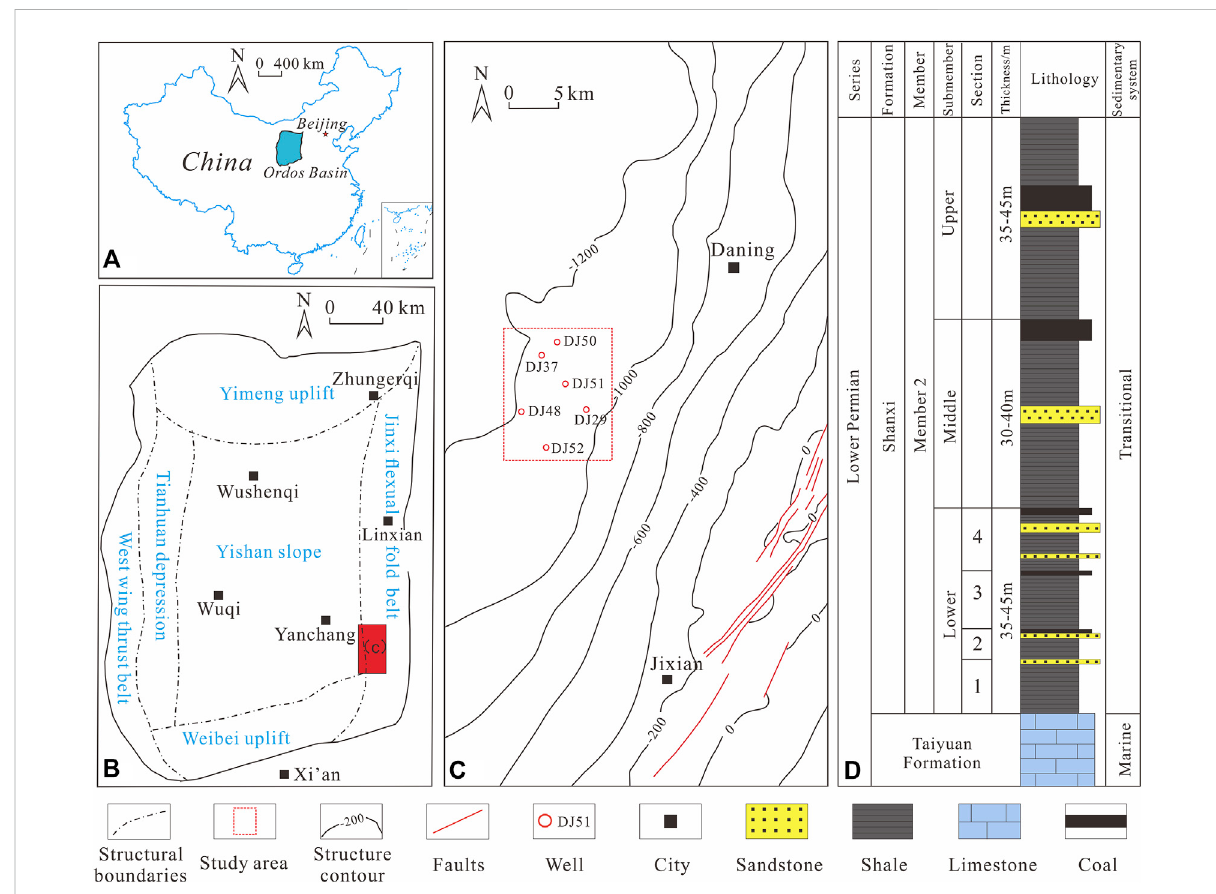
FIGURE 1 (A) Location of the Ordos Basin in China. (B) Regional structure map of the Ordos Basin. (C) Tectonic map of the study area. (D) Stratigraphic maps of the Shan-2 Member in the Shanxi